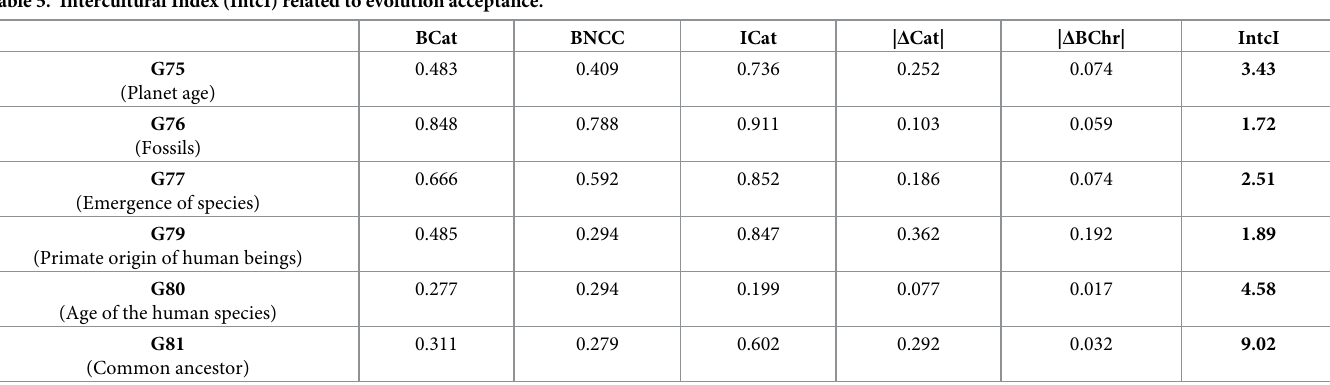
Table 5. Intercultural Index (IntcI) related to evolution acceptance.